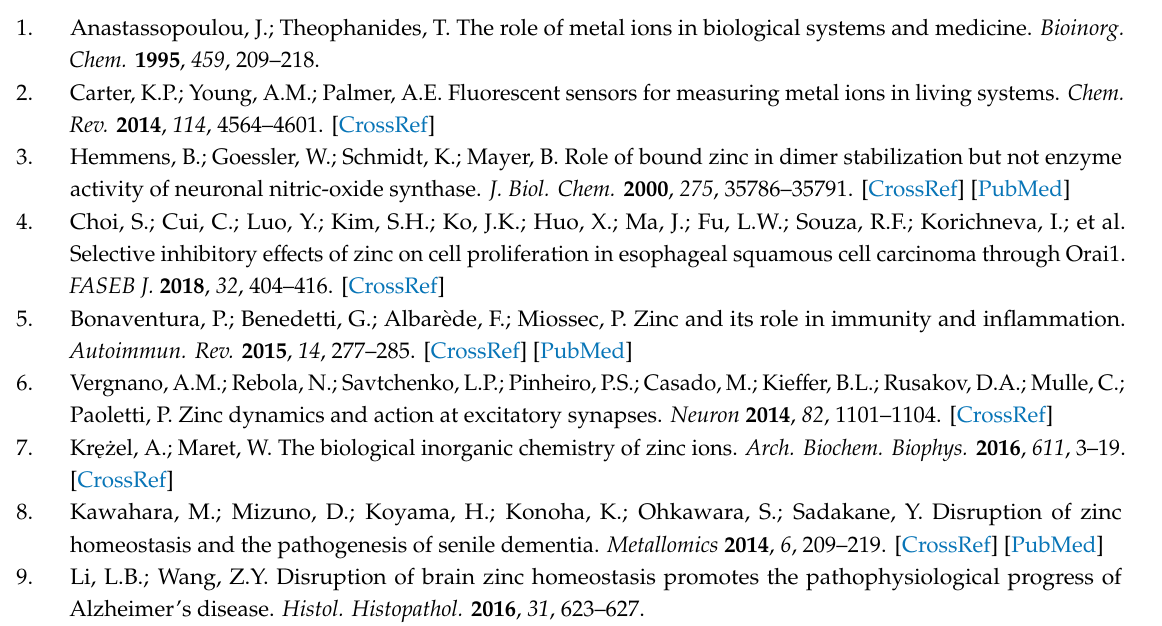
Figure S1: Job’s plot analysis of (a) 3a (10 − 5 M, λ em = 381 nm); ( b ) 3b (10 − 5 M, λ em = 367 nm); ( c ) 4a (10 − 5 M, λ em = 353 nm); ( d ) 4b (10 − 5 M, λ em = 360 nm); ( e ) 5a (10 − 5 M, λ em = 377 nm); ( f ) 5b (10 − 5 M, λ em = 395 nm). The total concentration of each compound and Zn 2 + are 10 µ M in HEPES bu ff er (100 mM, 5% DMSO, pH = 7.4). λ em = emission wavelength. Figure S2: Typical Benesi-Hildebrand analysis of ( a ) 3a , ( b ) 3b , ( c ) 4a , ( d ) 4b , ( e ) 5a and ( f ) 5b . Figure S3: Fluorescence responses of ( a ) 3a (10 − 5 M, λ em = 381 nm); ( b ) 3b (10 − 5 M, λ em = 367 nm); ( c ) 4a (10 − 5 M, λ em = 353 nm); ( d ) 4b (10 − 5 M, λ em = 360 nm); ( e ) 5a (10 − 5 M, λ em = 377 nm); ( f ) 5b (10 − 5 M, λ em = 395 nm) upon addition of Pb 2 + in HEPES bu ff er (100 mM, 5% DMSO, pH = 7.4). λ em = emission